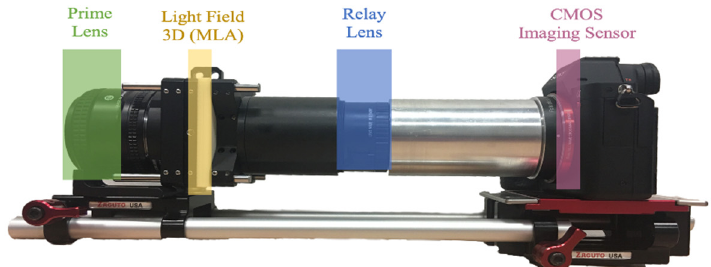
Figure 2. 3D integral Imaging camera PL: Prime lens, MLA: Microlens array, RL: Relay lens and CMOS Imaging Sensor [21].